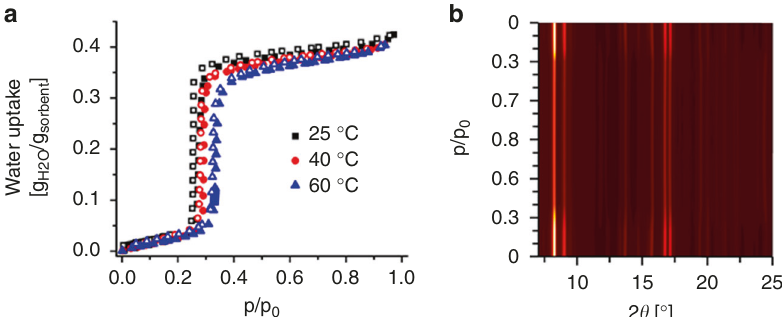
Fig. 2 Water sorption properties of CAU-23. a Water sorption isotherms recorded at three different temperatures ( fi lled symbols = adsorption; empty symbols = desorption). b PXRD patterns of CAU-23 at different relative water pressure values